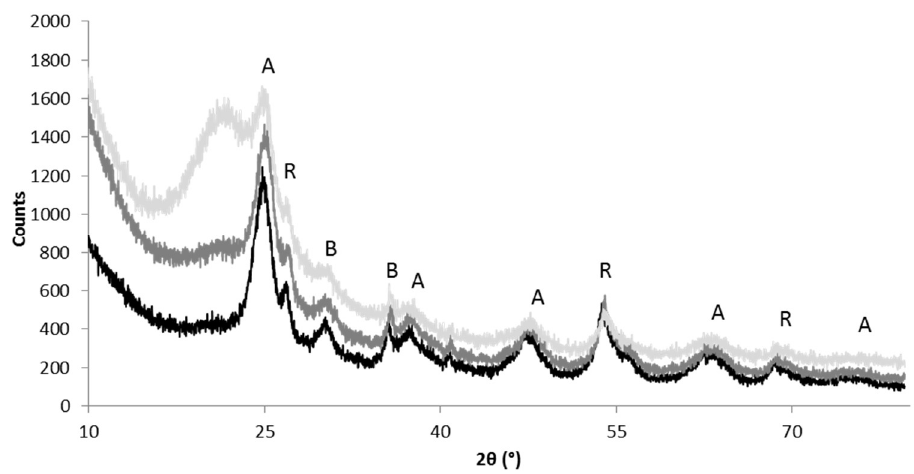
Figure 3. X-ray diffractograms of TiO 2 SiO 2 3:1 (black), TiO 2 SiO 2 1:1 (medium gray) and TiO 2 SiO 2 1:3 (light gray). (A = anatase; B = brookite; R = rutile).